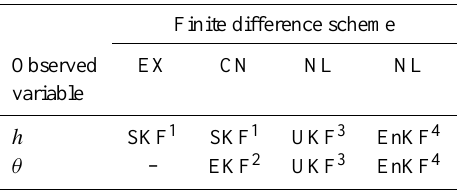
Table 1. Summary of assimilation algorithms adopted in combi- nation with different numerical schemes and different types of ob- served